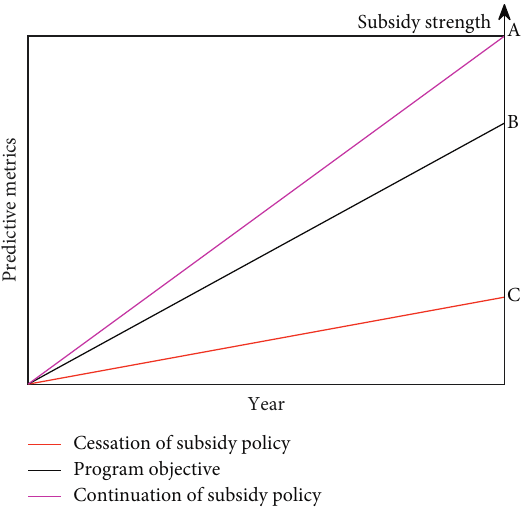
Figure 6: Subsidy strategy model